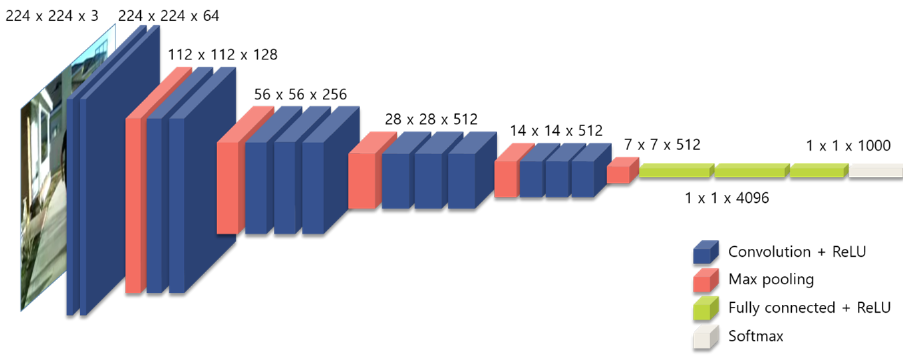
Figure 1. VGG16 network architecture.